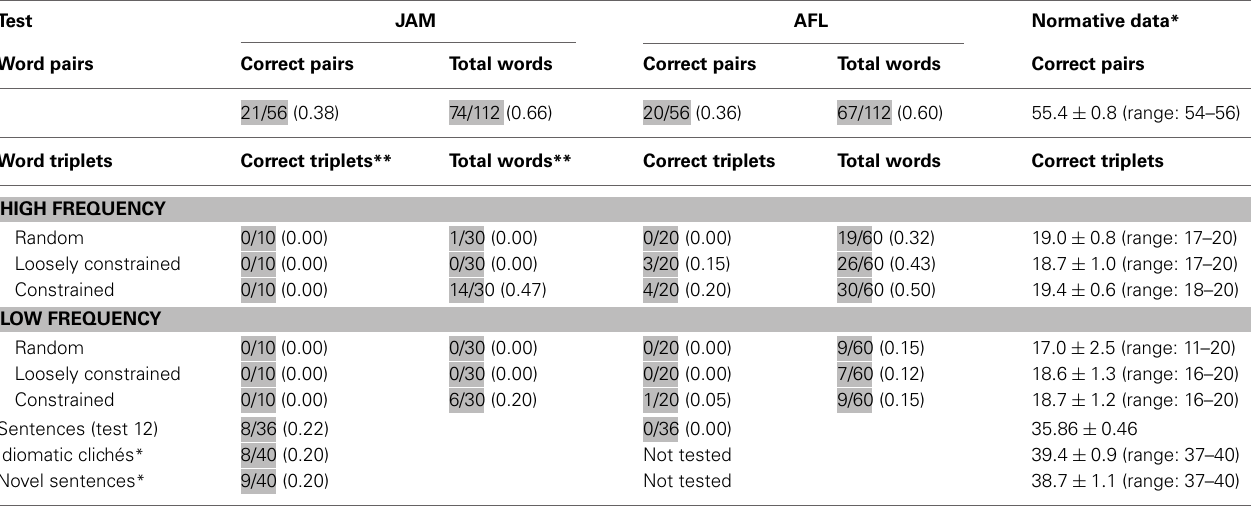
Table 3 | Auditory processing: repetition of word pairs, word triplets, sentences, and